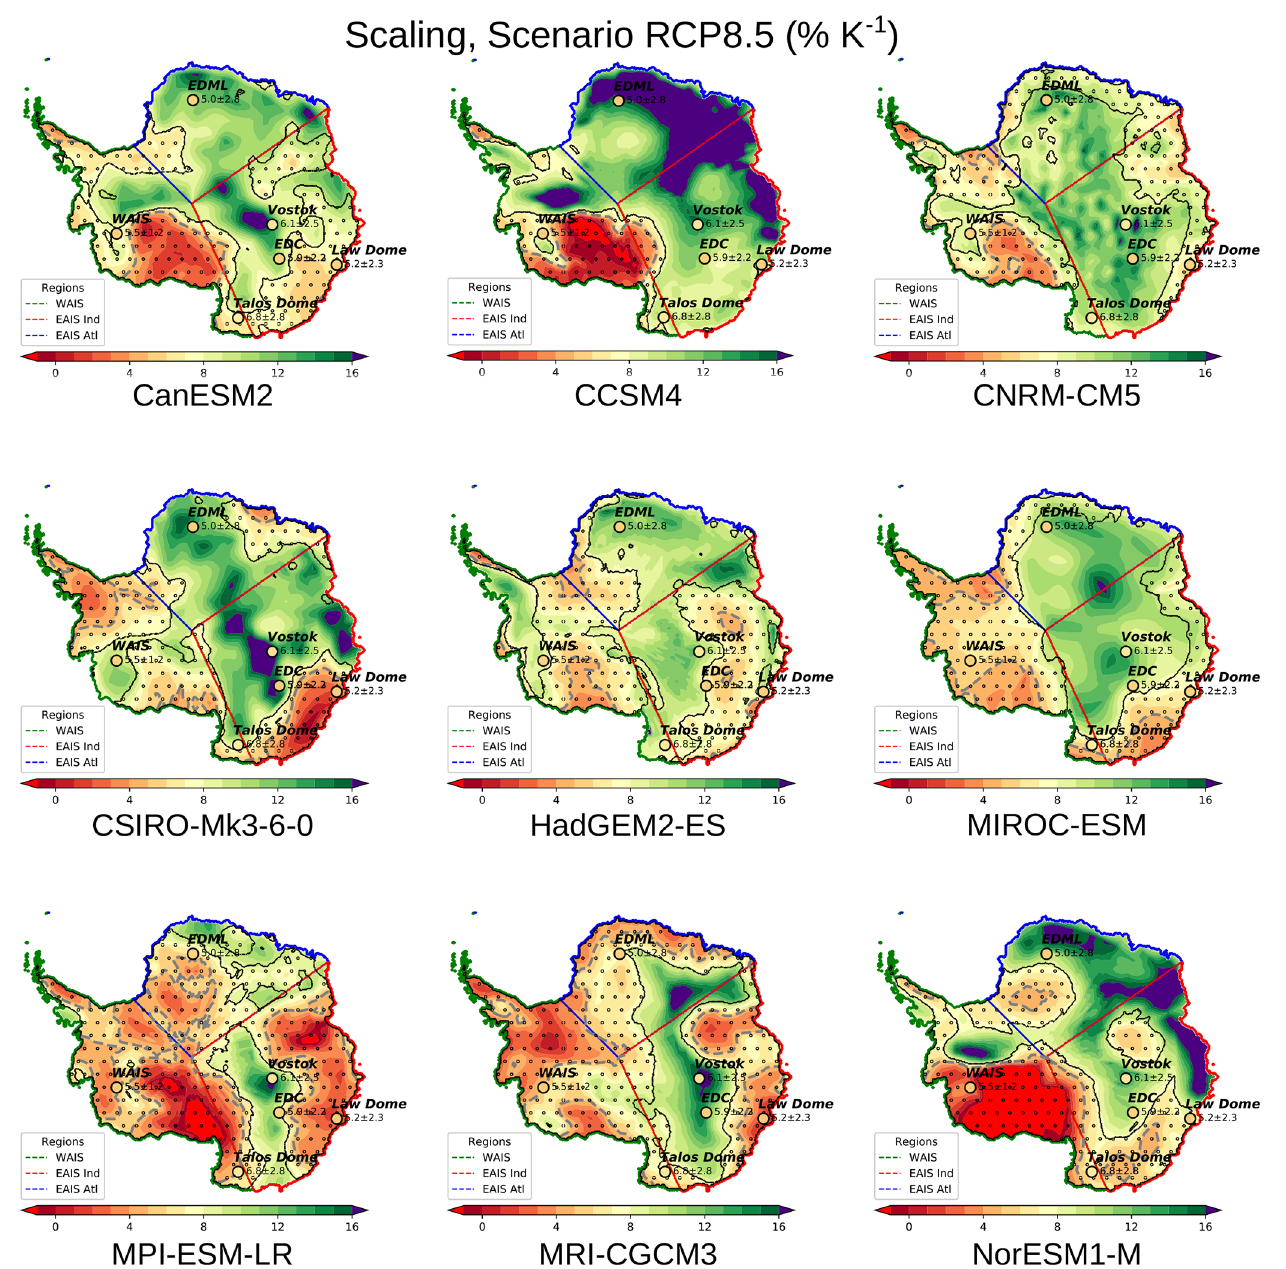
Figure E3. Air-temperature-scaled precipitation under the RCP8.5 scenario for nine CMIP5 models (Table 1) for the period from 2051 to 2100. The ice sheet simulations are driven by anomalies relative to the first 50 years of the related piControl climate scenario. In the dotted regions enclosed by black contours, the combined simulated scaling and the standard deviation contain the value of 5%K − 1 . Gray dashed lines follow this 5%K − 1 contour. The scaling values deduced from ice cores are shown at their location (mean and the 2 σ uncertainty). The “WAIS,” “EAIS Atl,” and “EAIS Ind” region boundaries are outlined in green, blue, and red, respectively (lower left legend). For further details, the reader is referred to Sect. 3.2. Figure 4 shows the corresponding CMIP5 data set average. The contours of the Antarctic continent are deduced from Fretwell et al.